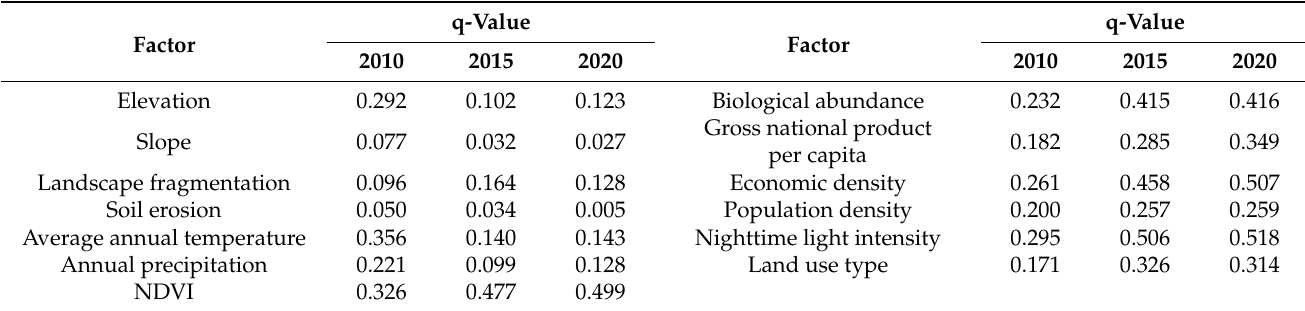
Table 6. Factor detector results.